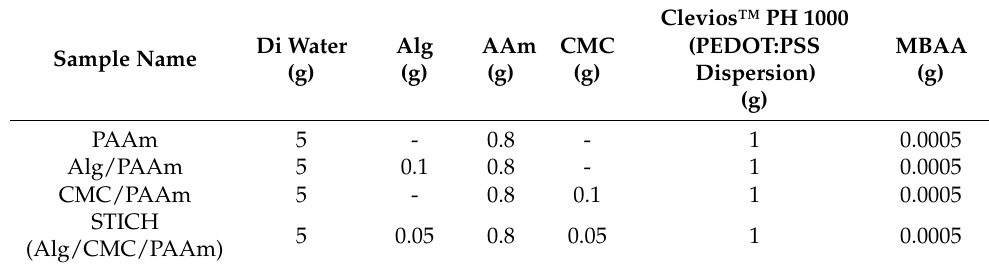
Table 1. The precursor compositions of different Alg, CMC, and PAAm-based conductive